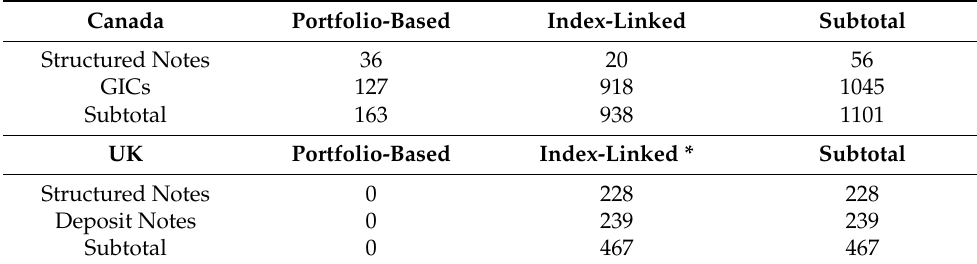
Table 2. Product distribution by